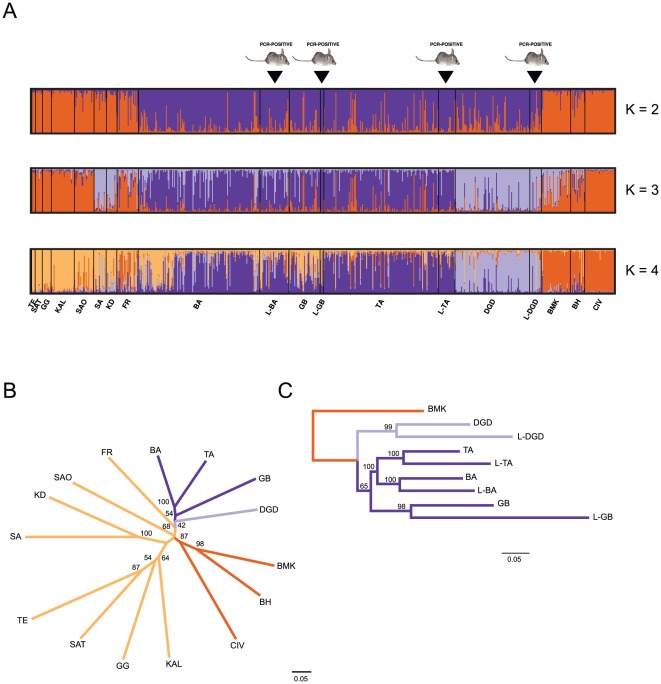
A) M. natalensis populations clustering based on Structure Bayesian inference (K = 2 to 4); Burn-in period = 150,000; MCMC repeat length = 200,000).Each color represents one assumed population cluster K. Multiple colored bars display an individual's estimated membership proportion in more than one population (q), i.e. the admixture level. The labels correspond to the sampling location indicated in table S1. It should be noted that PCR-positive and PCR-negative rats collected in a same location belong to the same source population according to structure. B) Neighbor-joining (NJ) phenogram summarizing Cavalli-Sforza & Edwards' (1967) DCE chord distances among 15 populations of M. natalensis collected in Guinea. Values on the nodes represent the percentage of bootstrap replicates over individuals (n = 100). Branch lengths are proportional to the genetic distance between the different populations and the scale bar represents a distance DCE of 0.05. Population codes are defined according to Table S1. C) The same phylogenetic reconstruction as shown in (B) but with a partition of the LASV positive and negative rats into sub-populations. The Bamakama sample was used as an out-group.